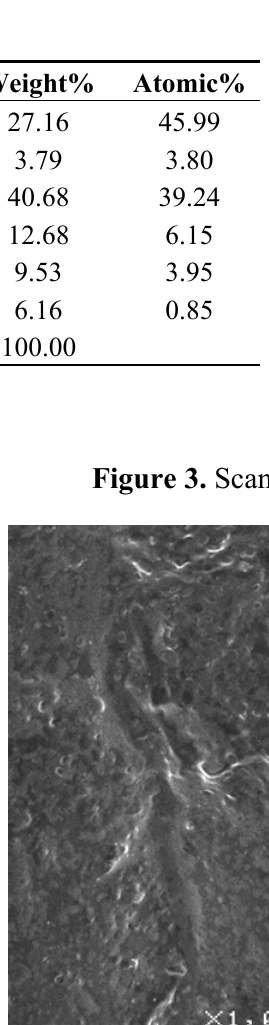
O nanocomposite. 2 4